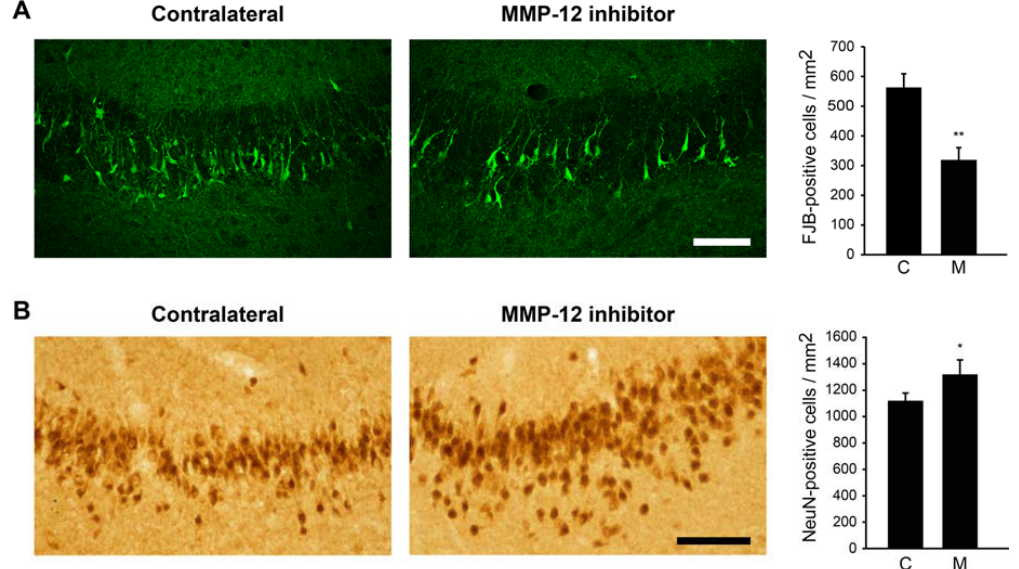
Figure 1. Effect of MMP ‐ 12 inhibition on neuronal cell death and survival in the CA3 hippocampal region of rats after pilocarpine ‐ induced SE. Brain sections were stained for Fluoro ‐ Jade B (FJB) ( A ) to evaluate neuronal cell death or against NeuN ( B ) to evaluate neuronal survival. The specific MMP ‐ 12 inhibitor significantly prevents the appearance of FJB ‐ positive cells in the CA3 pyramidal layer compared to the contralateral hemisphere, while it increases neuronal survival, as illustrated by an increase in the number of NeuN ‐ positive cells, indicating a neuroprotective effect. Quantification was performed using ImageJ. C = contralateral hemisphere, M = MMP ‐ 12 inhibitor. Data are shown as mean ± SEM. n = 7. * p < 0.05, ** p < 0.01; Student’s t ‐ test. Scale bar: A = 50 μ m, B = 100 μ m.